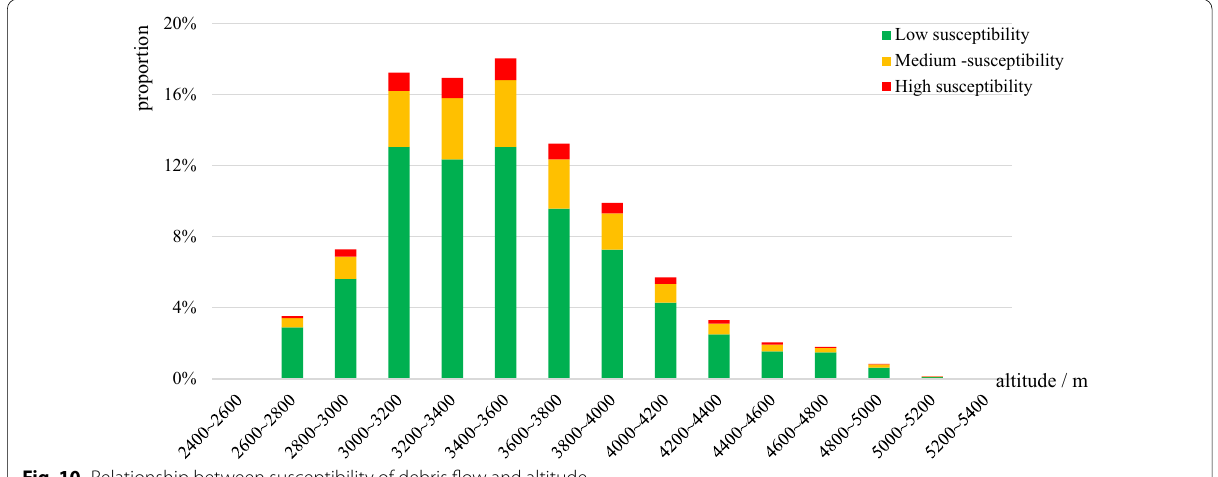
Fig. 10 Relationship between susceptibility of debris flow and altitude